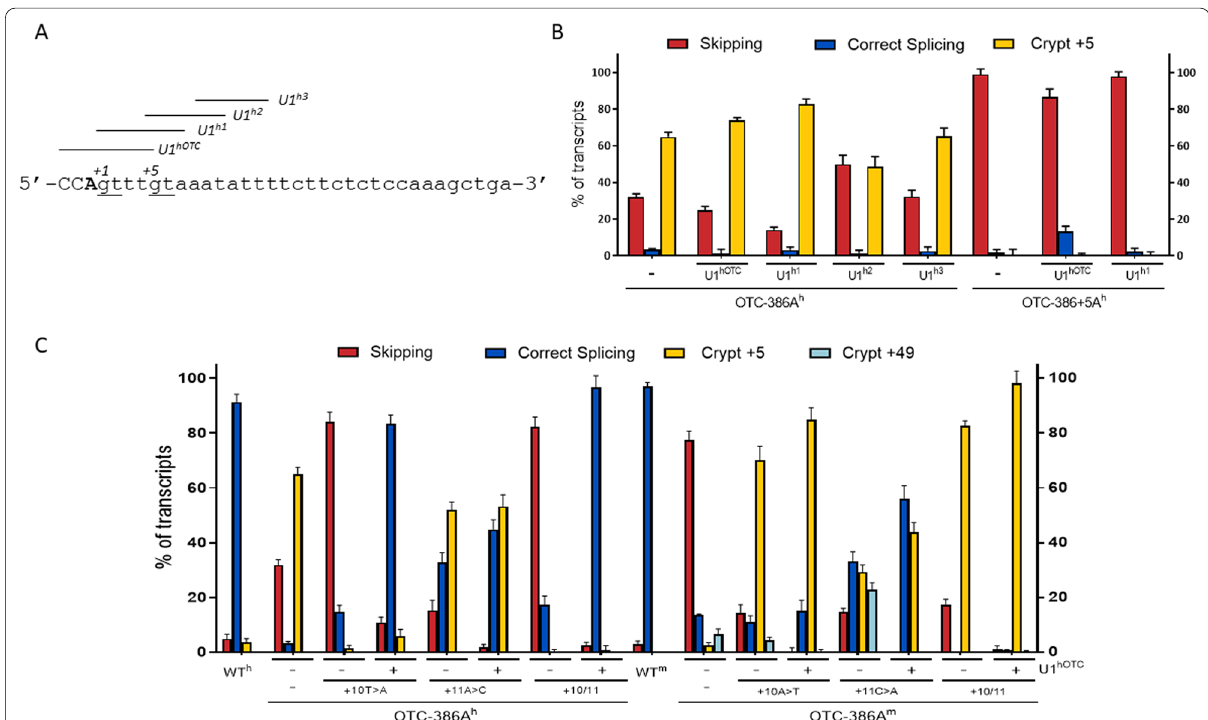
Fig. 5 The strong cryptic 5 ′ ss prevents U1snRNA-mediated correction in the human context. A Genomic sequence of the human OTC exon 4 exon–intron junction, with exonic and intronic nucleotides in upper and lower cases, respectively. The c.386G>A change is indicated in bold. The regions targeted by modified U1 h of the corresponding pre-mRNA are reported on top. B Splicing patterns in HepG2 transiently transfected with OTC h -386A or OTC h -386 5a minigenes alone or in combination with engineered U1 h , and expressed as bar plots indicating the relative + percentage of each transcript. Results are expressed as mean SD from three independent experiments. C Splicing pattern in HepG2 or Hepa1-6 ± cells transiently transfected with human and mouse OTC minigenes differing at 10-11 positions alone or in combination with the corresponding + U1 hOTC designed on the mutated 5 ′ ss. Bar plots indicate the relative percentage of each transcript and results are expressed as mean SD ±